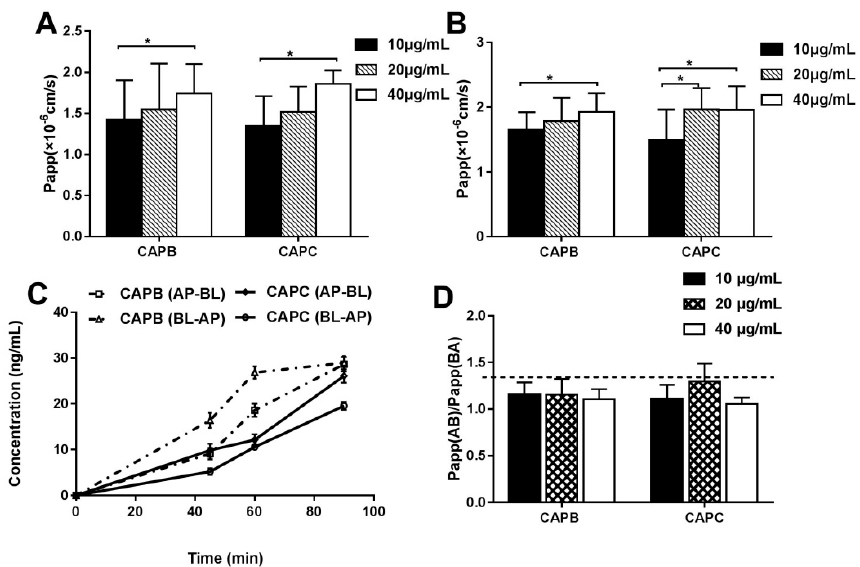
Figure 2. Bidirectional transport studies of capilliposide B (CAPB, A ), capilliposide C (CAPC, B ) at different initial drug concentrations (10, 20 and 40 µ g/mL). p < 0.05 (*), comparison with the 10 µ g/mL capilliposides (CAPs) group. The apparent permeability (P app , cm/s) values of CAPB and CAPC at 0, 45, 60 and 90 min ( C ). The P app (BA)/P app (AB) values of CAPB and CAPC were at different initial drug concentrations (10, 20 and 40 µ g/mL) ( D ). All results are expressed as mean ± S.D. (n = 3).